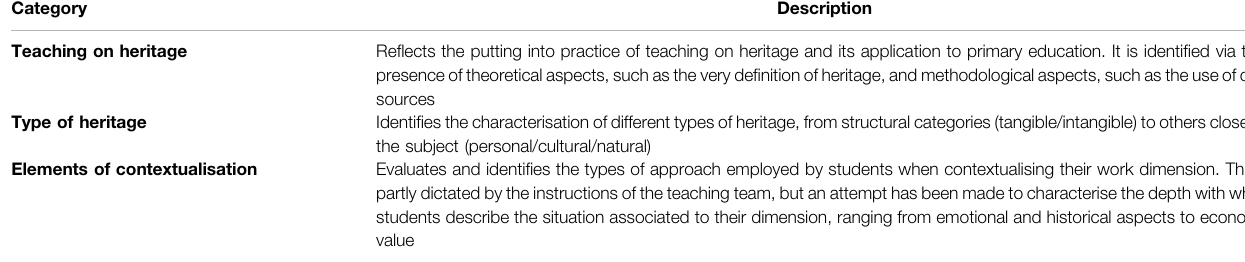
TABLE 3 | Categories of analysis of the written work on the Way of St. James. Category